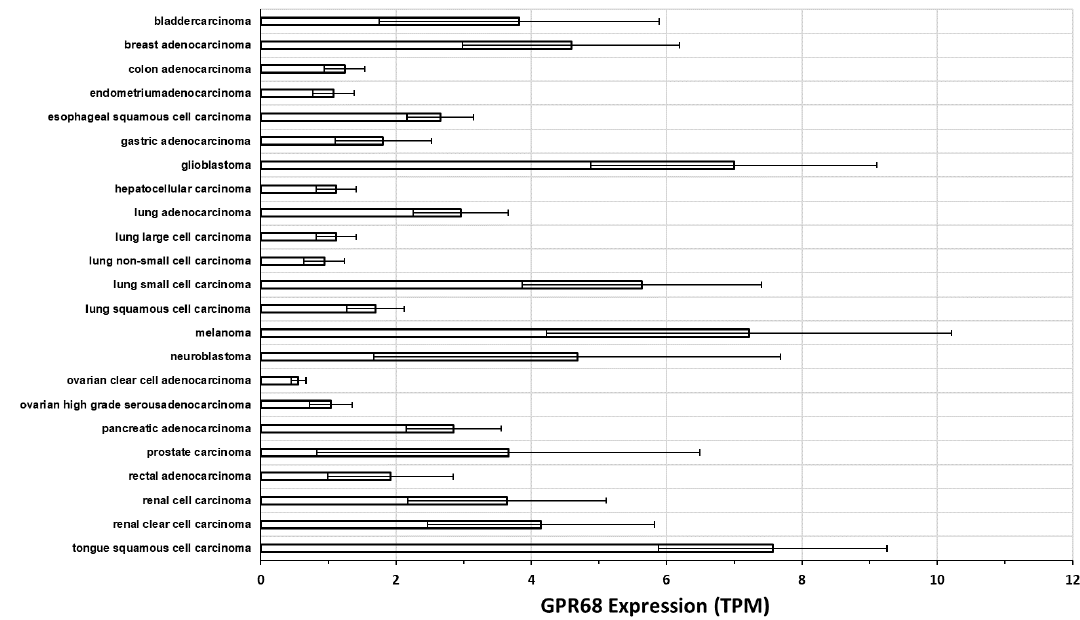
Figure 5. GPR68 expression in cancer cell lines from a range of tumor types. These data were generated by RNA-seq, quantified in transcripts per million (TPM) and analyzed via the iRAP pipeline [66], from the Cancer Cell Line Encyclopedia [65] accessed via the EMBL-EBI expression atlas. GPR68 expression is plotted as mean and standard error of the mean (SEM) across all cell lines.